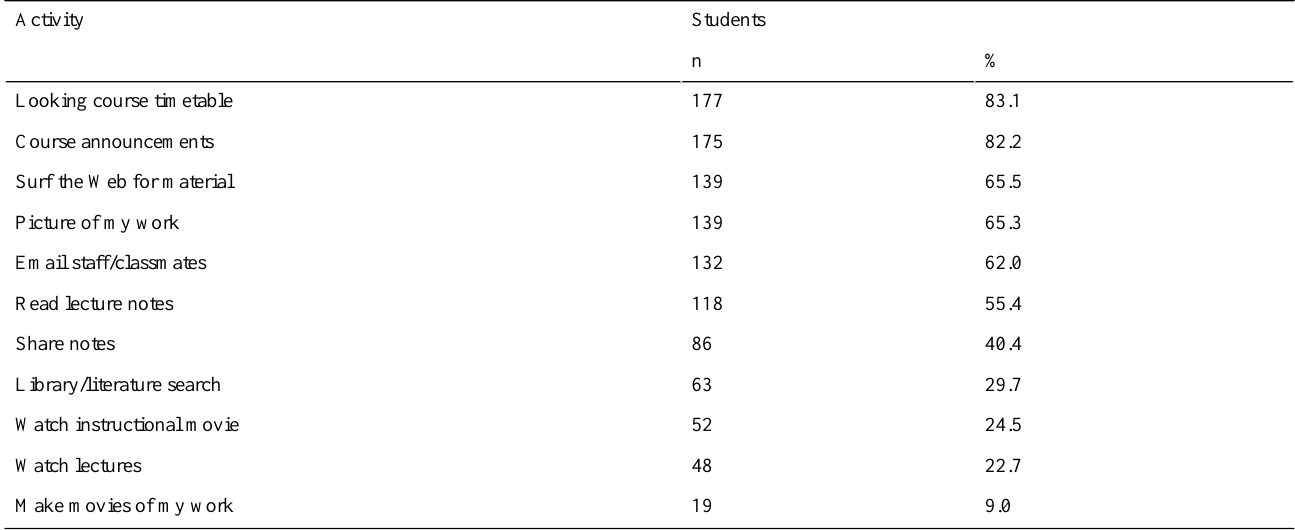
Table 2. Number and percentage of students using their smartphones for learning activities.